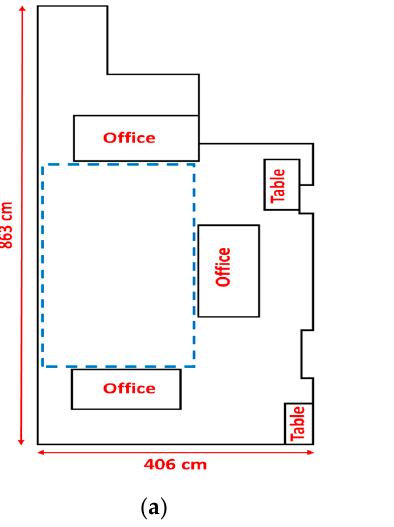
Figure 4. ( a ) The proposed indoor map for experimental validation of path planning techniques on the 4OWMR ( b ) An example of an inflated map.